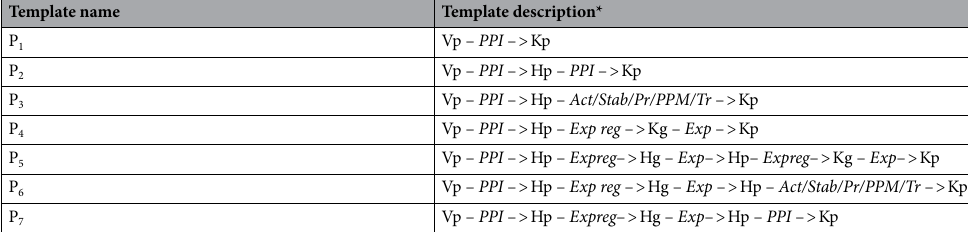
Table 2. Templates for virus-host interaction pathways. Interactions: PPI protein–protein interactions, Act/Stab/Pr/PPM/Tr regulation of activity or stability, or proteolysis, or post translational modifications, or transport (release). Exp reg regulation of gene expression. Exp gene expression (protein production). *Objects: Vp SARS-CoV2 proteins, Kp KEGG metabolic pathway proteins, Kg KEGG metabolic pathway genes, Hp any host proteins inv olved in the interactions, Hg any host genes involved in the